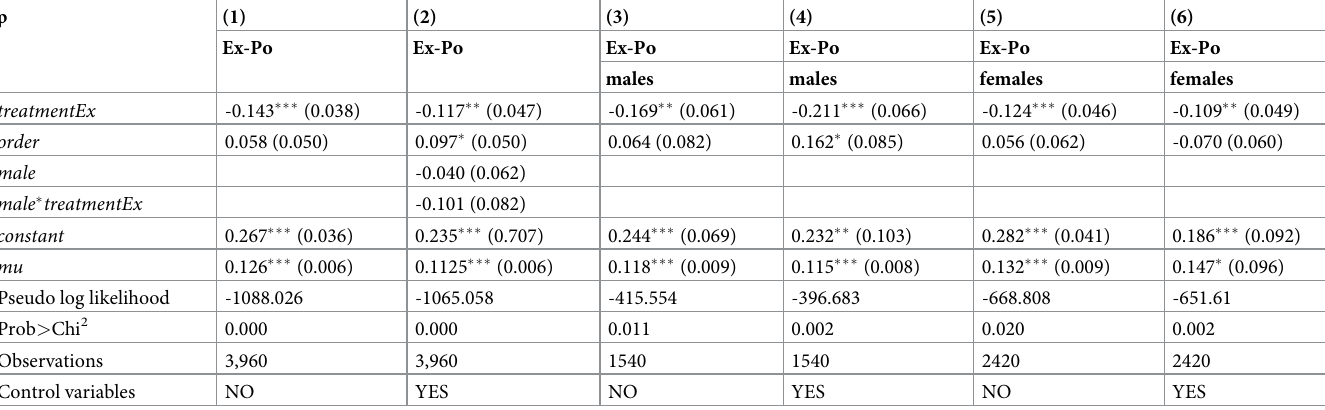
Table 8. The effect of framing. Maximum likelihood estimation of the risk aversion coefficient, r